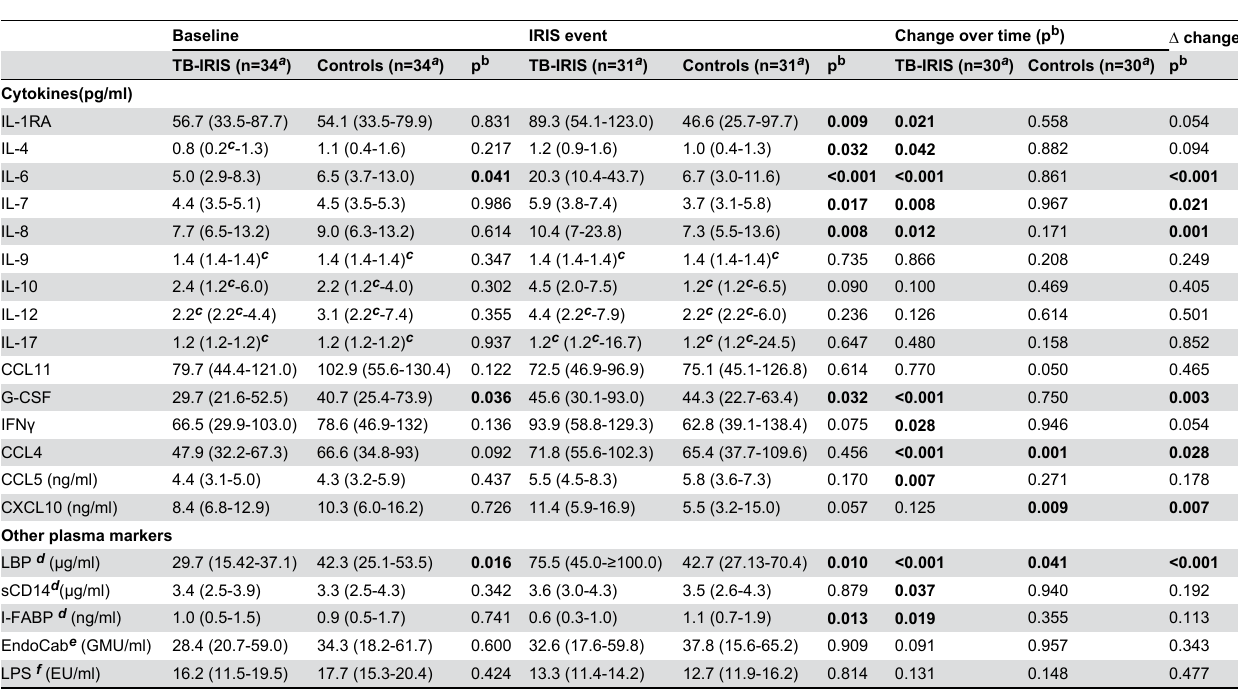
Cytokine levels are shown as median values with inter-quartile range. Values were compared between matched patient pairs per time point and between time points per study group. Level of significance was set to p < 0.05.Differences between patients for IL-9 and IL-17 were analyzed with a McNemar test. IL-2 (LOD 2.0 pg/ml ) , GM-CSF (LOD 20.4 pg/ml ) and TNFα (LOD 8.8 pg/ml ) were excluded from analysis. a Some patients were not included due to insufficient sample volume or pairwise exclusion. b Wilcoxon signed-rank test unless stated otherwise. c Values were below detection limit and represented as LOD/2. d Baseline n= 38, IRIS event n = 38. e Baseline n= 35, IRIS event n = 35. f Baseline n= 11, IRIS event n = 13. P-values in the final column represent the difference between delta (∆ ) values over time of TB-IRIS cases and